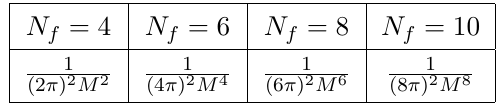
Table 1 . The leading part of Z N f